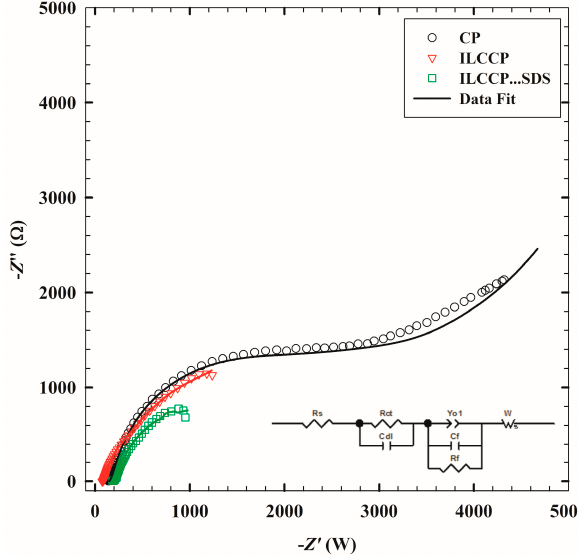
Figure 3. Typical impedance spectrum presented in the form of the Nyquist plot for CPE ( ○ ), ILCCPE ( ) and ILCCPE…SDS ( ). (Symbols and solid lines represent the experimental measurements